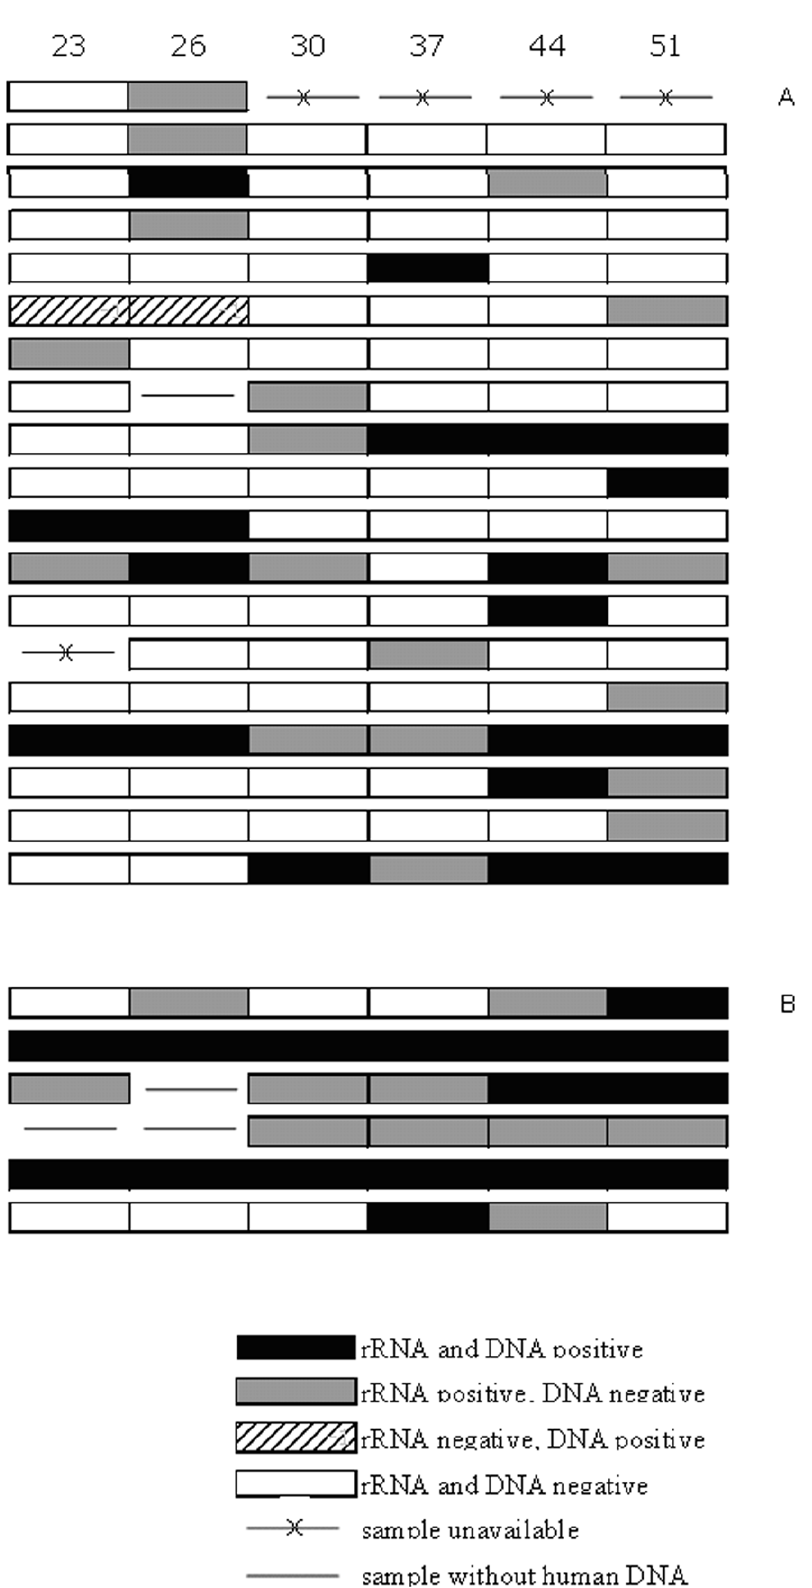
Figure 1. Cervicovaginal (a) and anorectal (b) Chlamydiatrachomatis rRNA and DNA detection between 23 and 51 days post directly observed Azythromycin treatment. Each row represents a cervicovaginal or anorectal Ct infection. Twenty five infections (out of 59) had at least one positive sample between 23 and 51 days post-treatment and these 25 infections are displayed here. Self taken swabs were tested for Ct rRNA (TMA, Tigris; GenProbe, San Diego, US) and plasmid DNA (real-time in house PCR; Amsterdam, the Netherlands) [12]. doi:10.1371/journal.pone.0034108.g001 PLoS ONE | www.plosone.org